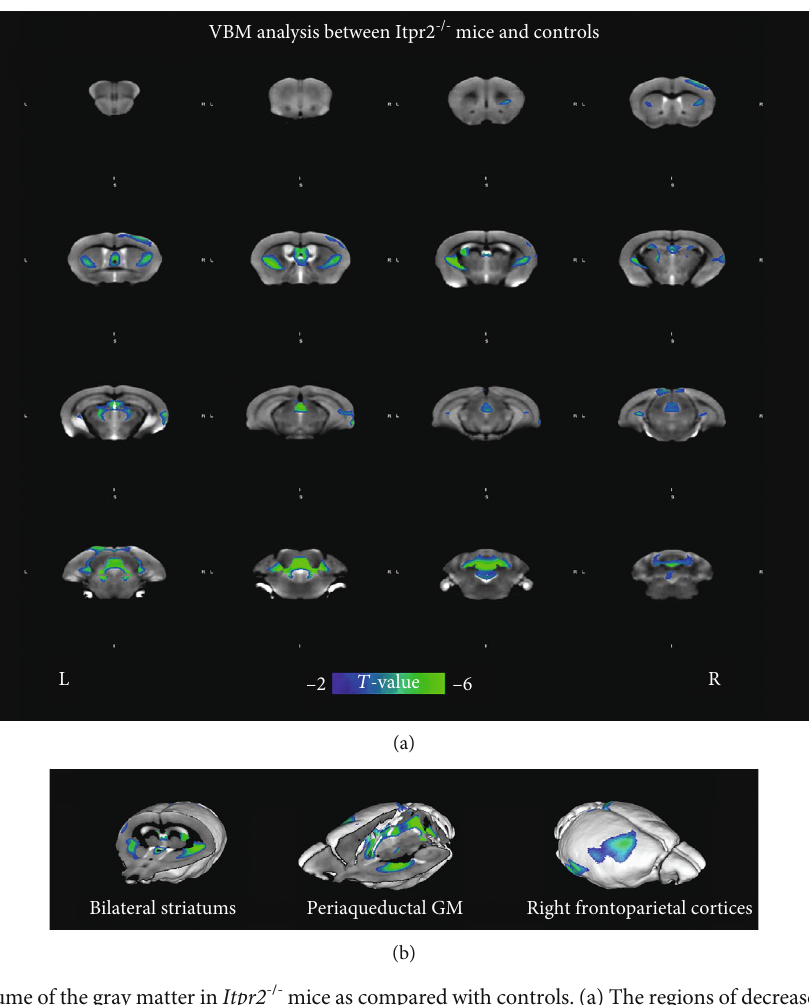
Figure 2: Abnormal volume of the gray matter in Itpr2 -/- mice as compared with controls. (a) The regions of decreased volume of gray matter shown on the coronal plane. (b) The regions of decreased volume of gray matter shown on the three-dimensional images.